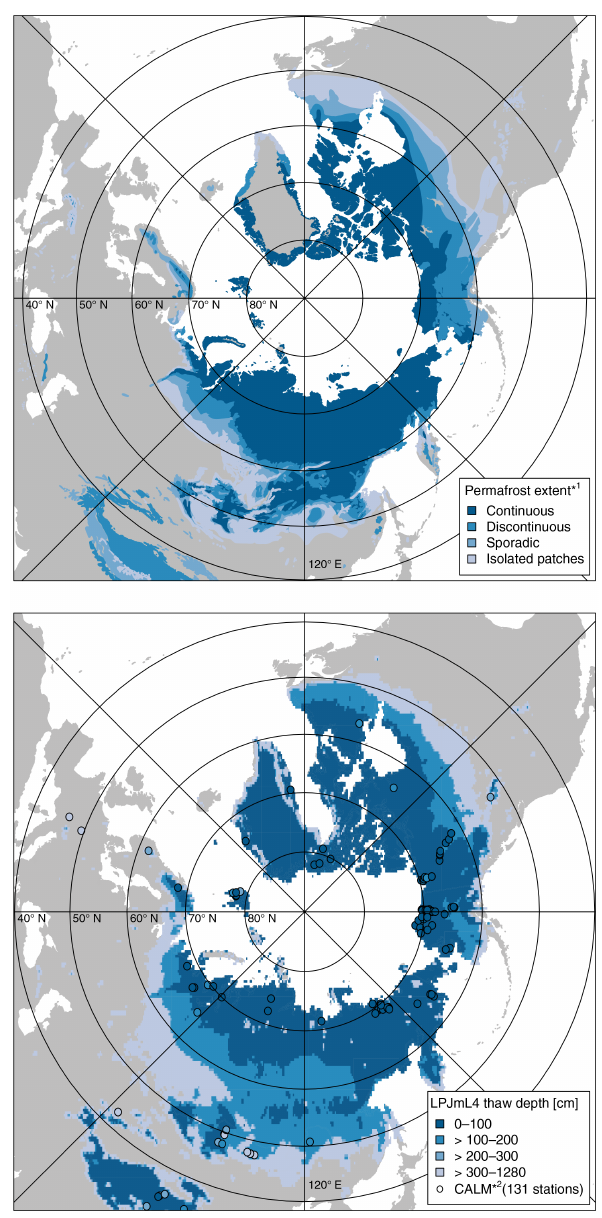
Figure 9. Observed and simulated permafrost distribution and ac- tive layer thickness. (a) Contemporary permafrost extent accord- ing to the IPA Circum-Arctic Map of Permafrost ( ∗ 1 Brown et al., 1998). (b) LPJmL4-simulated active layer thickness compared to the ∗ 2 CALM station data means both for the observation time 1991–2009 (https://www2.gwu.edu/~calm/; Brown et al., 2000). The colour scheme used at the bottom is the same for simulated thaw depth and Circumpolar Active Layer Monitoring (CALM)